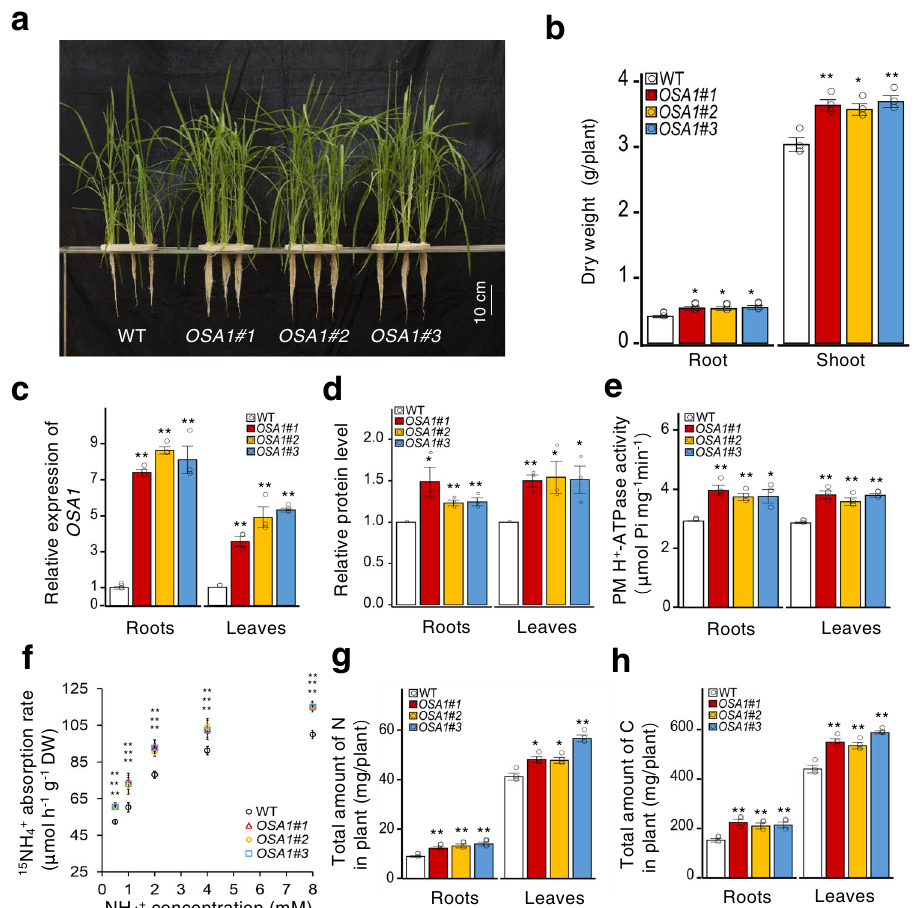
Fig. 2 OSA1 overexpression promotes nitrogen (N) and carbon (C) uptake in rice. a Phenotypes of 4-week-old WT and OSA1 -overexpressing (ox) plants. b Dry weights of WT and OSA1 -ox plants. c Relative OSA1 expression levels in WT and OSA1 -ox plants. d Relative PM H + -ATPase protein levels in WT and + absorption rates in the roots of WT and OSA1 -ox plants under OSA1 -ox plants. e Hydrolytic activity of PM H + -ATPase in WT and OSA1 -ox plants. f 15 NH 4 different NH 4 + concentrations. To determine 15 NH 4 + absorption rates, seedlings were incubated with 0.5 – 8 mM 15 NH 4 + for 5 min to re fl ect the net uptake rate. g , h Total N and C levels in WT and OSA1 -ox plants. Plants were grown hydroponically in a greenhouse for 4 weeks. Small circles in b – h represent data points for individual experiments; three biological replicates were analysed for each treatment. Values in b – h are presented as the means ± SEs ( n = 3). Differences were evaluated using the two-tailed Student ’ s t test (* P < 0.05; ** P < 0.01). The exact P values are provided in the Source Data fi